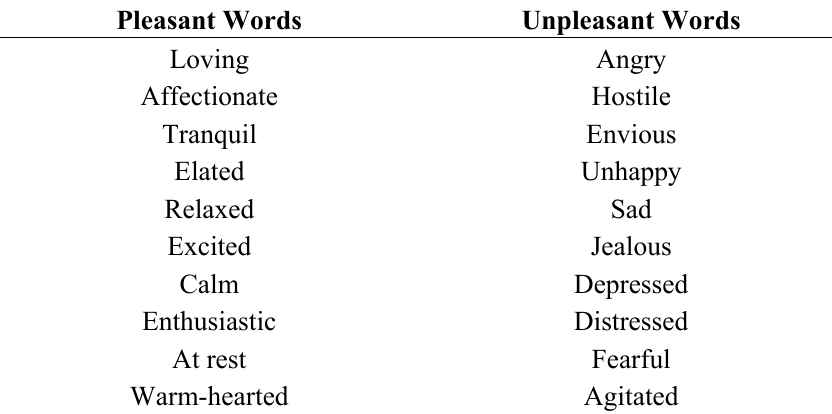
Table 3. Pleasant and unpleasant